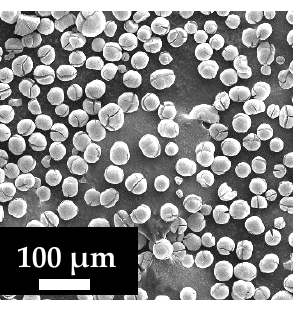
Figure 1. The SEM micrograph of TiO 2 particles used for membrane modifications.